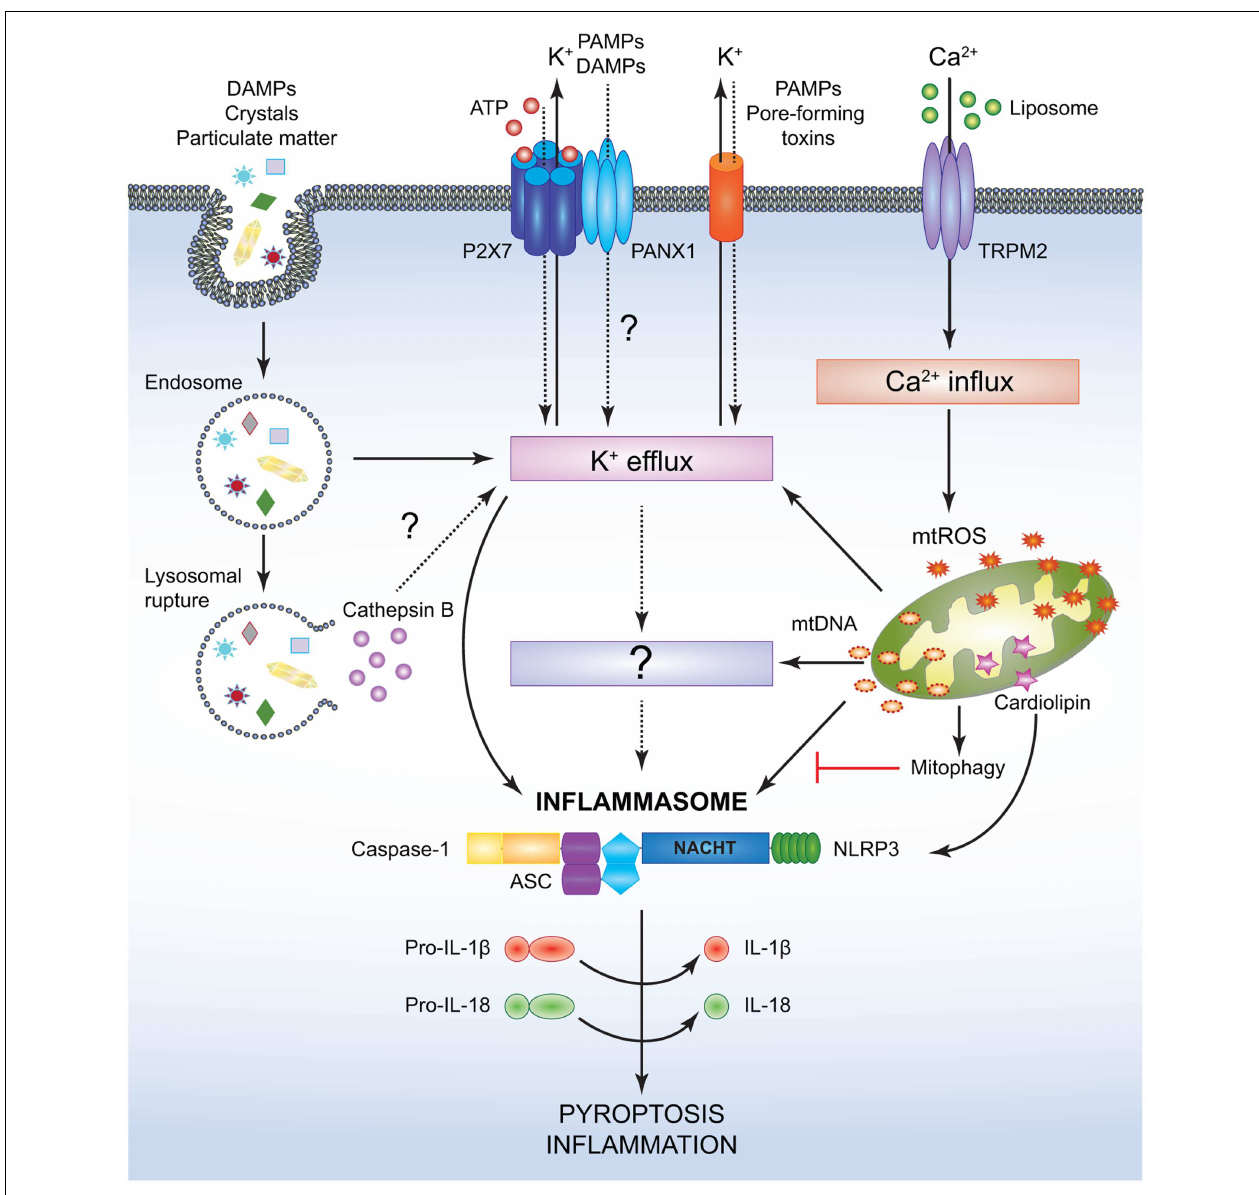
B. ATP binds to the P2X7 receptor on the cell membrane and causes opening of the PANX1 channels allowing K + efflux and influx of any PAMPs and DAMPs present in the extracellular space. PAMPs such as pore-forming toxins activate the NLRP3 inflammasome and facilitate K + efflux. Liposomes instigate Ca 2 + influx through opening of theTRPM2 channels. Accumulation of excessive Ca 2 + in the cytosol causes mitochondrial dysfunction and release of mtROS and oxidized mtDNA, which may activate the NLRP3 inflammasome either directly or by inducing K + efflux. Clearance of distressed mitochondria by mitophagy serves to evade such inflammasome activation. Mitochondrial Cardiolipin binds to NLRP3 and is required for the NLRP3-inflammasome activation. Following NLRP3-inflammasome assembly, caspase-1 undergoes proximity driven proteolytic cleavage and further processes pro-IL-18 and pro-IL-1 β into their mature active forms. Activation of the NLRP3-caspase-1 axis results in inflammation and pyroptotic cell